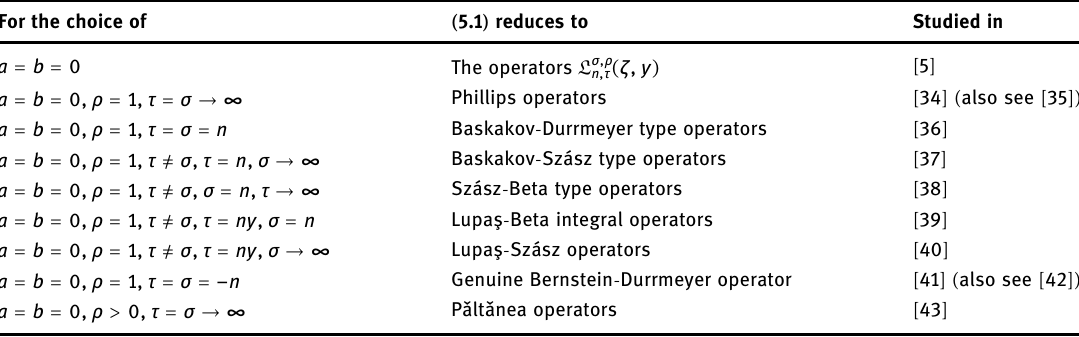
Table 1: The operators L ( ) ζ y , n τσ ρ a b ,, ,